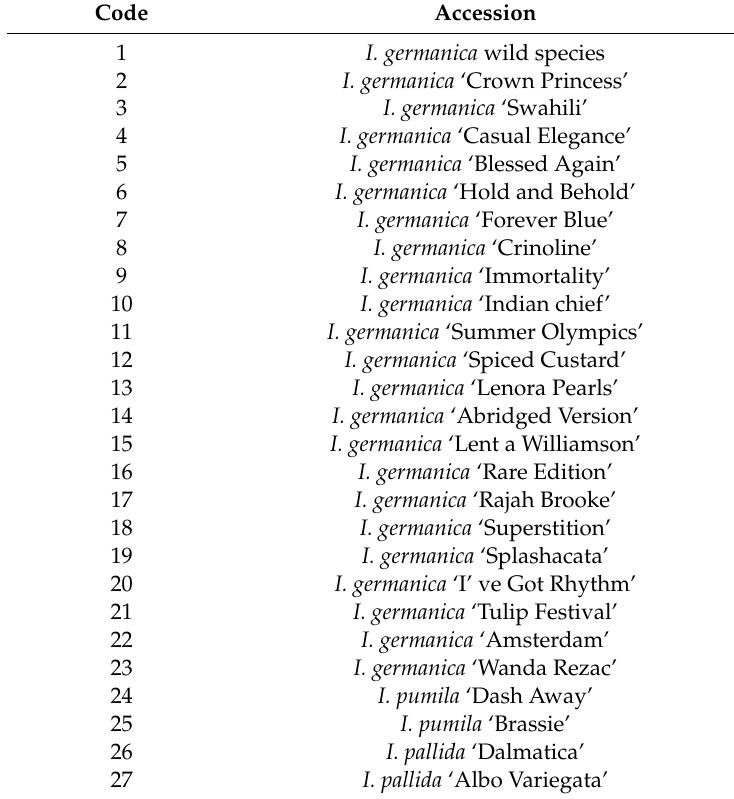
Table 3. Species and cultivars of bearded irises used in this